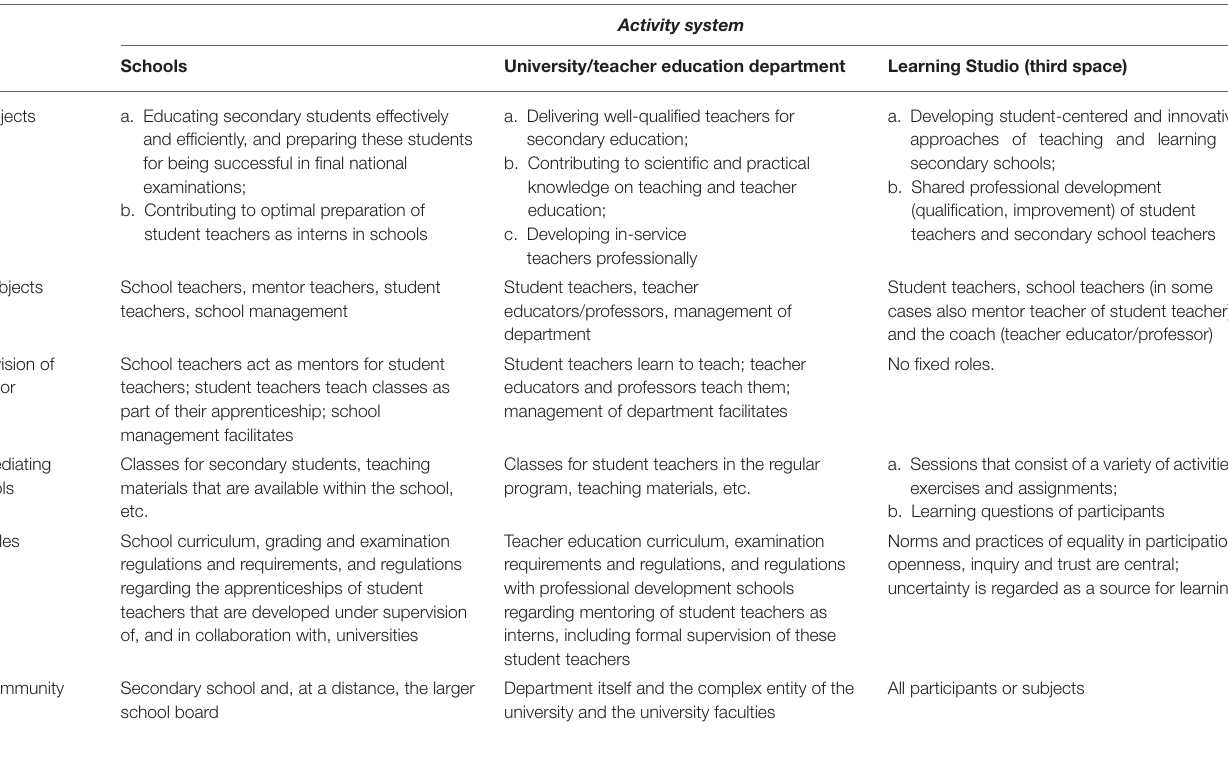
TABLE 2 | Elements of activity